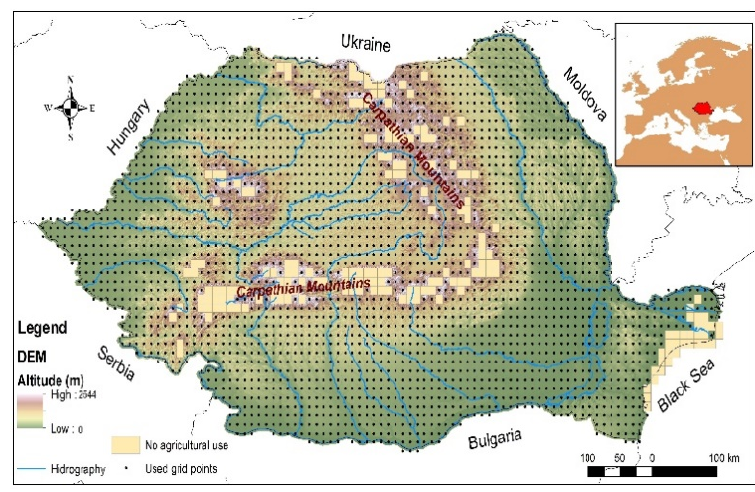
Figure 1. Grid network used for data analysis.